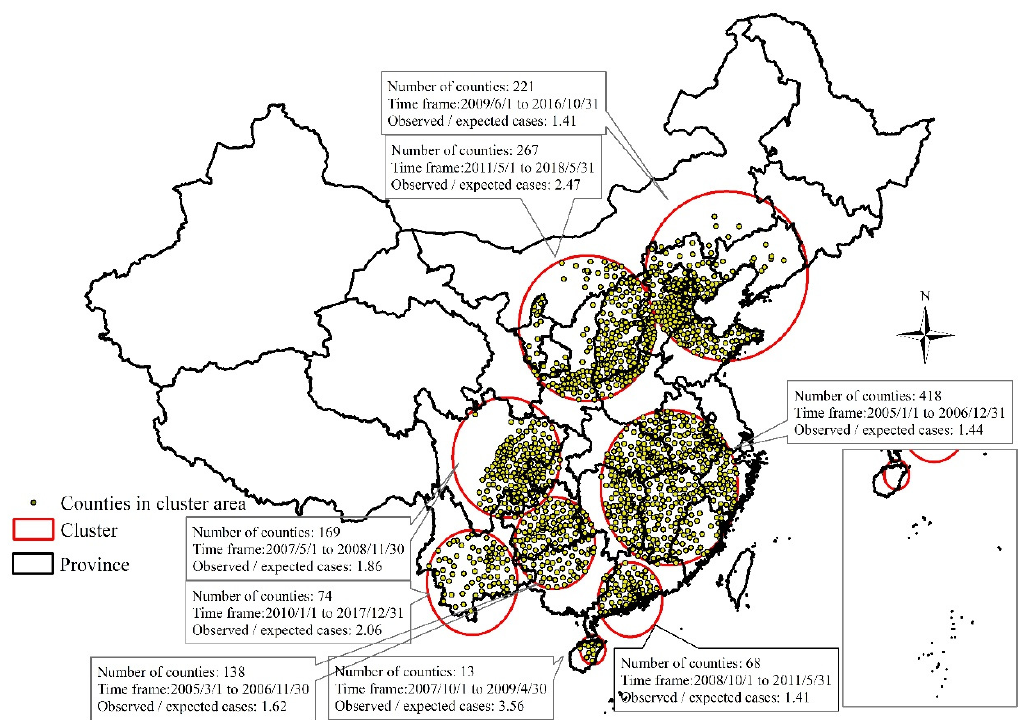
Figure 5. The retrospective space-time scan statistical analyses for human rabies from 2005 to 2020.